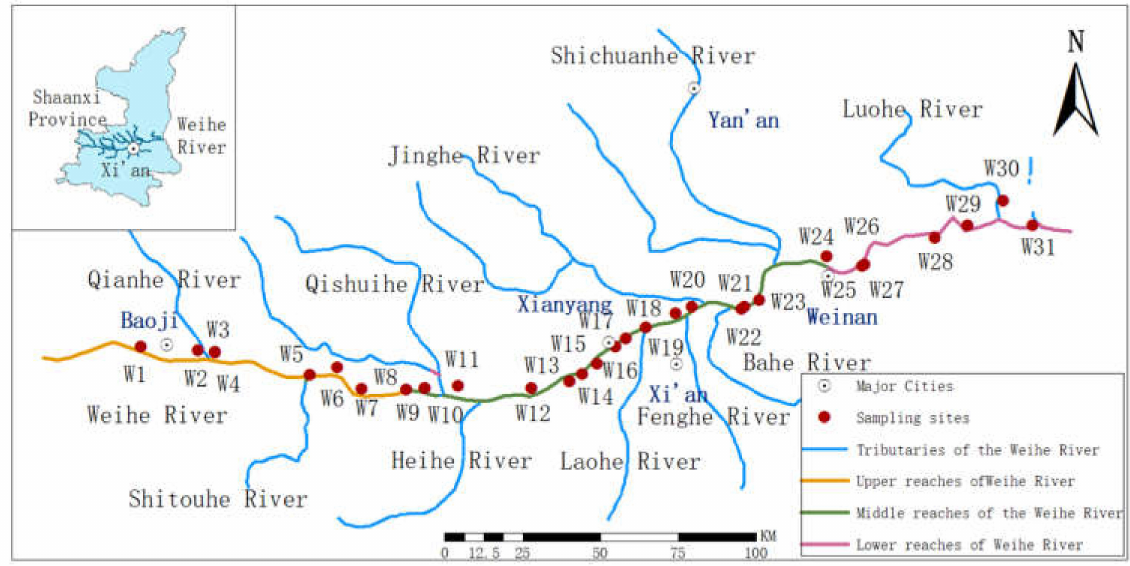
Figure 1. Distribution of sampling sites in Shaanxi section of the Weihe